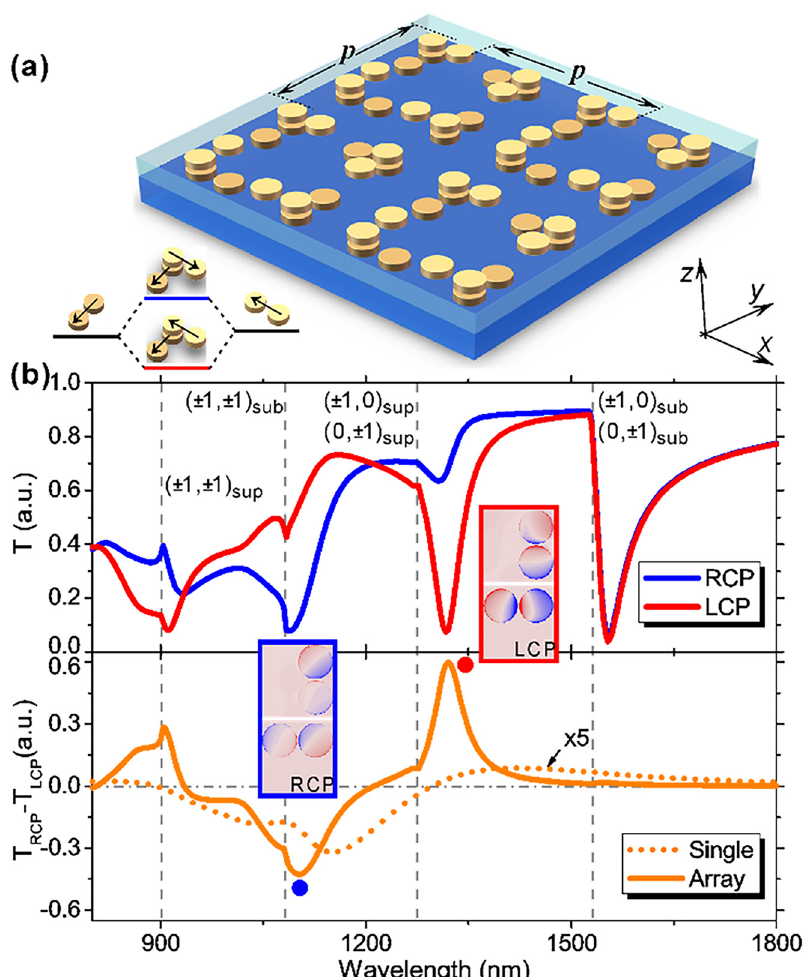
Figure 8: Enhanced CD spectra from chiral gold quadrumer arrays. (a) Schematics of the quadrumer array organized in C 4 symmetry. The supercell parameters are: period p =850nm,centerdistancebetween two adjacent quadrumer in a unit cell d = 430 nm, radius of the disk r = 80 nm, disk thickness t = 30 nm, gap size between the two disks on the same layer h = 10 nm, separation between the upper and lower layer s = 50 nm, and refractive index of the substrate n sub = 1.80 and the superstrate n sup = 1.50. Inset: the plasmon hybridization scheme between the longitudinal resonances of the two dimers on the upper and bottom layers. (b) The transmission (upper panel) spectra under RCP (blue lines) and LCP (red lines) incidences, and the corresponding CD in transmission of the array (solid line, lower panel).Inset:thechargedistributionsofthe two CD peaks. The dotted line is the ensemble CD in transmission calculated based on the single quadrumer by neglecting the coupling between unit cells (magni fi ed by 5 times for a better visualization), and the vertical dashed lines denote the spectral positions of